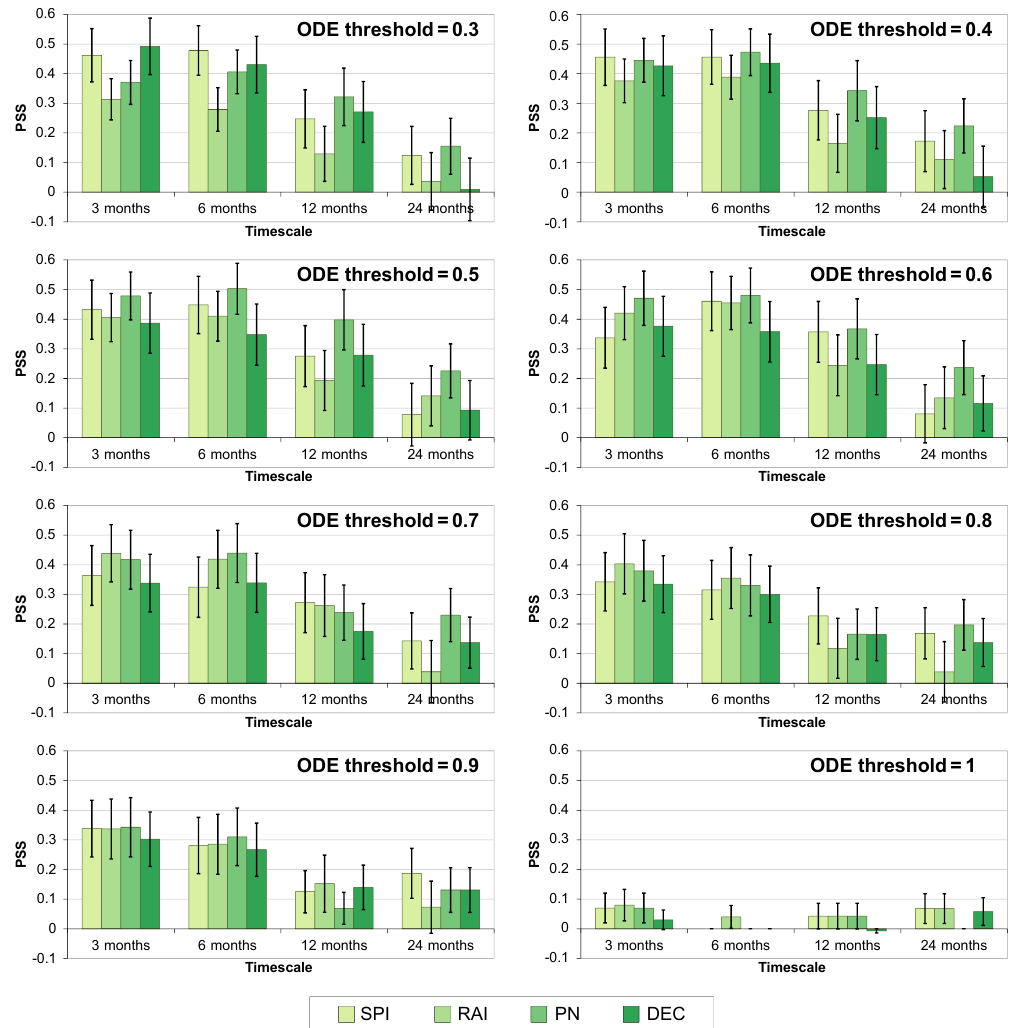
Figure B1. Graphical PSS results for different index and timescale combinations, for a range of ODE thresholds between 0.3 and 1. The black error bars represent the 95% confidence